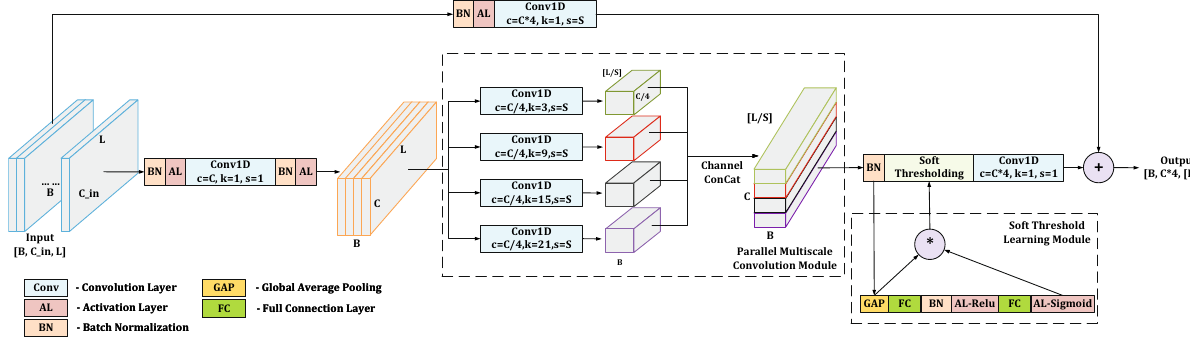
Figure 2. The structure of Multiscale Residual Unit (MSRU). Two hyper-parameters C and S will determine the output shape. The shape of input data is [ B , C _ in , L ] in which B represents batch size, C _ in represents channel number, and L represents data length. The shape of output data is [ B , C × 4, L / S ] . Hyper-parameters S is usually set to 1 or 2. Parallel multiscale convolution module consists of four convolutional layers with different kernel size and a channel concat operation. Soft Threshold Learning Module consists of a global average pooling layer and two fully connected nonlinear transformation layer. In every convolution layer, parameter c is the convolutional out channel number, k is the kernel size of convolution, and s is the stride of convolution. All the padding approach are